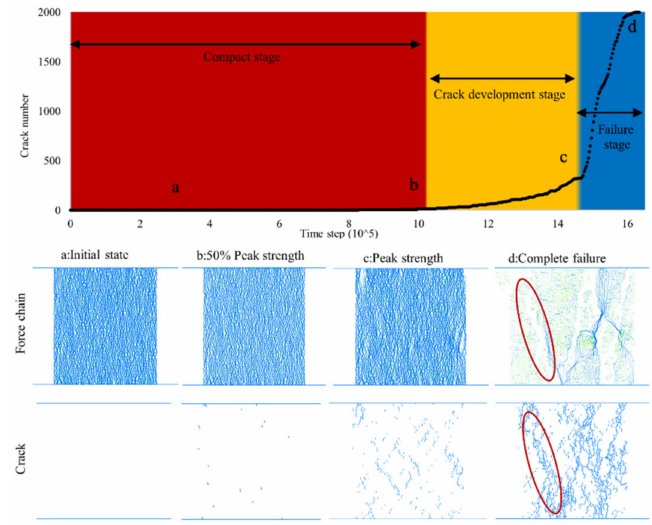
Figure 9. Force chain and crack development of 0.5% biopolymer treated sand under the uniaxial compressive test.